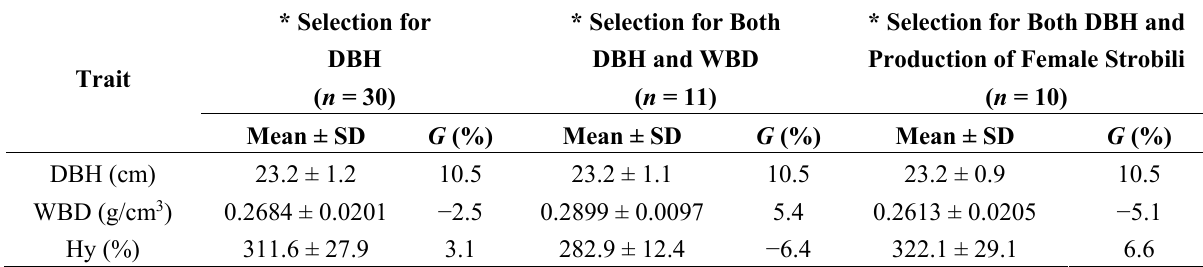
Figure 1. Two-dimensional clustering of the Chinese fir parent clones. DBH, diameter at breast height; WBD, wood basic density. The 12-year overall means were employed as a threshold (DBH and WBD); only the faster-growing clones (DBH > 21.0 cm) are marked. Conifer breeding commonly concentrates on the selection of trees for growth and flowering. When selection was placed on DBH and the production of female strobili, 10 faster-growing parent clones (p4, p5, p6, p7, p18, p237, p238, p243, p272, and p285) were identified; this selection demonstrated a gain of 10.5% for DBH, but resulted in a loss of WBD ( G = −5.1%). Table 4. Responses in DBH, WBD and Hy when different selection criteria were used for the 62 Chinese fir breeding parents at age 12. DBH, diameter at breast height; WBD, wood basic density; Hy, wood hygroscopicity; G , realized gain. * Selection was carried out in the 62 Chinese fir breeding parents using the overall mean of DBH and/or WBD as a threshold; production of female strobili was at medium to high